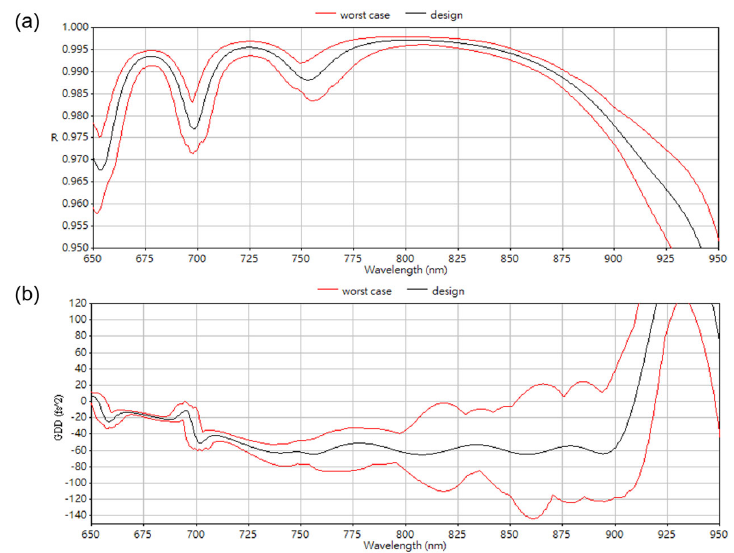
Figure 10. Simulated effects in optical properties at 1% normal Gaussian distribution for each layer thickness error. ( a ) Reflectance response, ( b ) GDD response.